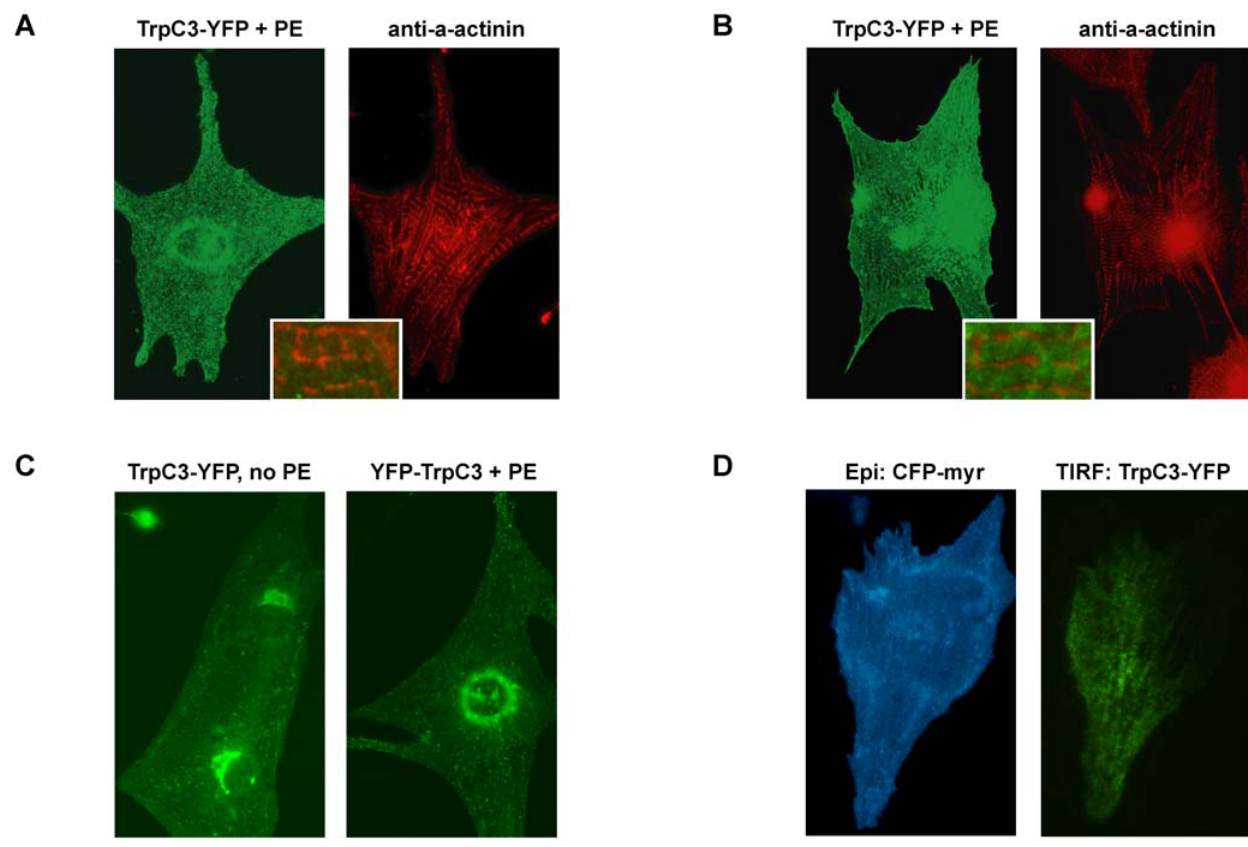
Figure 6. TrpC3 channel localization is distinct from that of Ca V 1.2. ( A–B ) Epifluorescence microscopy images of fixed myocytes expressing TrpC3 C- terminally tagged with YFP (TrpC3-YFP). Cells were stimulated for 48 hours with PE to induce hypertrophy. The majority of cells display a punctate and perinuclear pattern of TrpC3-YFP (example shown in A , left panel ). Co-staining with anti- a -actinin antibodies ( A , right panel ) reveals the localization of the Z-lines, which are closely apposed to the t-tubules. Magnifying a merge of the TrpC3-YFP and anti- a -actinin images ( A , inset ) shows little overlap between TrpC3-YFP puncta and the Z-lines. In some transfected myocytes, TrpC3-YFP puncta are completely excluded from the Z-lines (example shown in B , inset ). ( C ) TrpC3-YFP expressed in a serum-starved, un-hypertrophied myocyte ( left panel ) is also distributed in puncta. The same punctate pattern is also observed in hypertrophied myocytes ( right panel ) expressing TrpC3 with an N-terminal YFP tag (YFP-TrpC3). ( D ) Live myocytes co-transfected with CFP-Myr (a marker of the plasma membrane) and TrpC3-YFP were imaged by epifluorecence and total internal reflection (TIRF) microscopy. CFP-Myr imaged by epifluorescence ( left panel ) illustrates the extent of the plasma membrane. A TIRF image of TrpC3- YFP ( right panel ) indicates that, in live myocytes, tagged TrpC3 is found in puncta within 200 nm of the cell